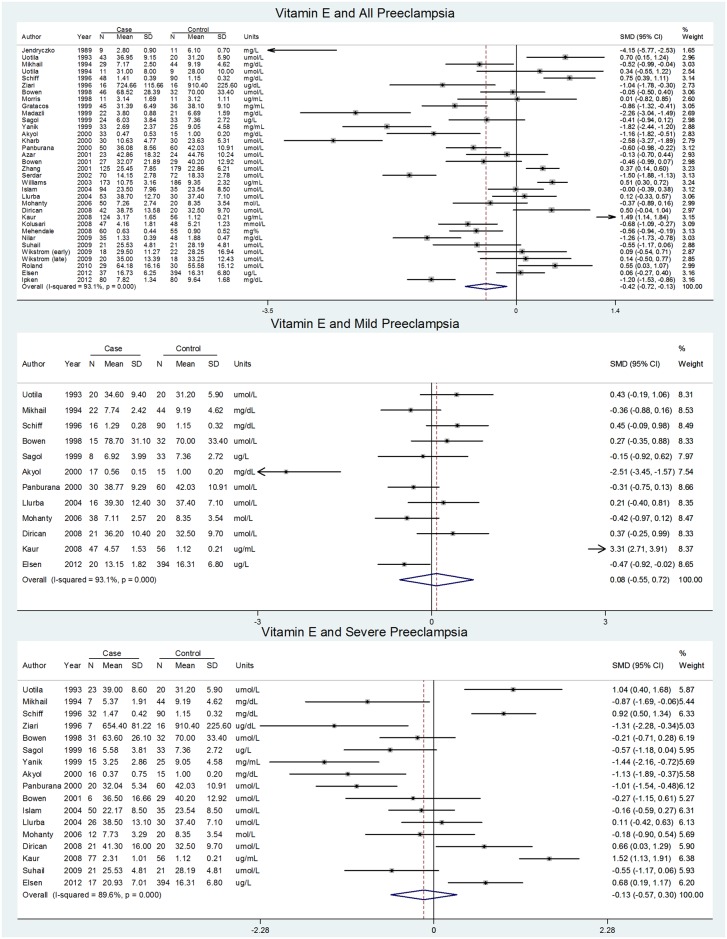
Forest plots for vitamin E and preeclampsia containing raw data.